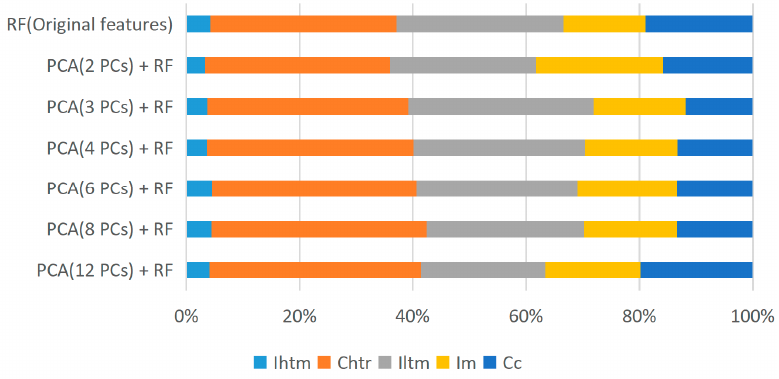
Figure 16. Proportion of each geological unit in Mare Fecunditatis and its vicinity with di ff erent methods.